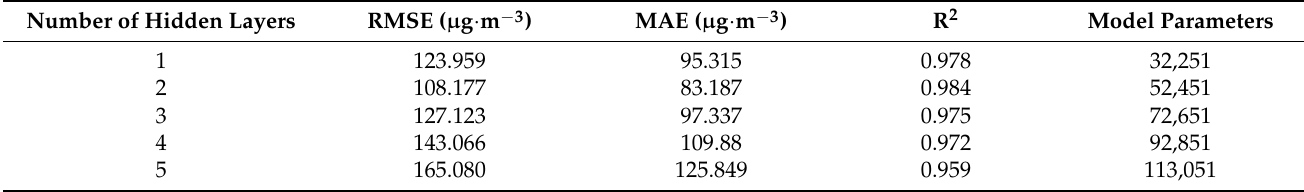
Table 4. Indicators for number of hidden layers in the model.